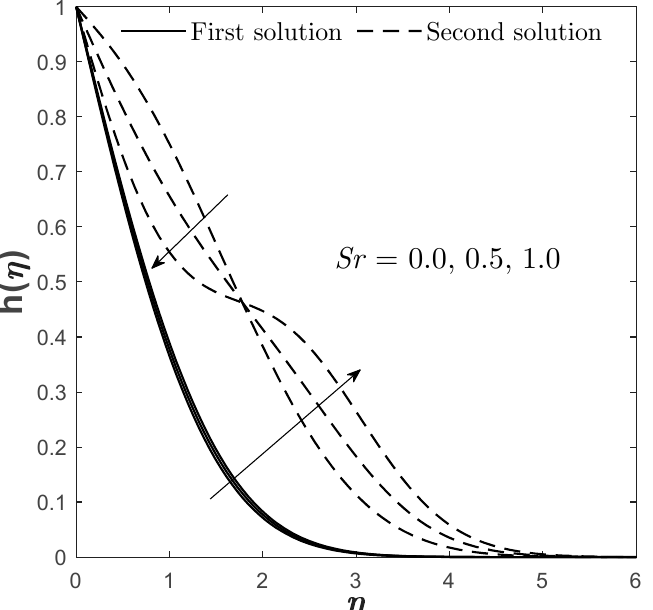
Figure 19. Plots of h ( η ) for varied Sr when N = Rd = Sc = 1, Du = 0.03, λ = − 1, Bi = 0.1, and φ 2 =